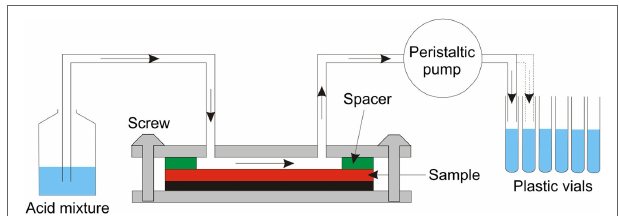
taBLe 1 | nominal chemical composition of the investigated float